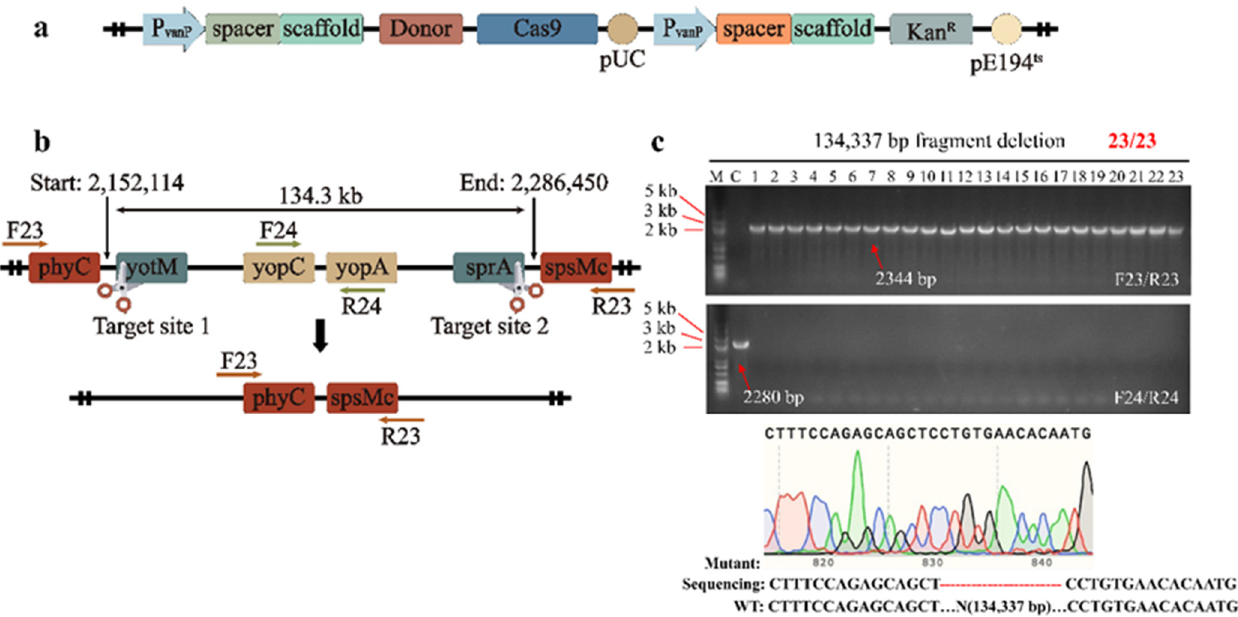
Figure 3. The design of 134.3 kb long fragment deletion ( a ) Construct of plasmid pCas-sgRNA-X series for genomic deletion. Cas9 protein was expressed by a mannose-induced promoter and sgRNAs were expressed by a constitutive promoter. ( b ) Deletion of 134.3 kb genomic fragment in B. subtilis . ( c ) Representative PCR results of a 134.3 kb fragment deletion. Colonies were randomly picked for PCR screening, and a wild-type colony served as control (abbreviated to C). Primers F23/R23 and F24/R24 were used to prove the fragment was successfully deleted. If so, the F23/R23 would have a positive PCR result whereas F24/R24 would not obtain any